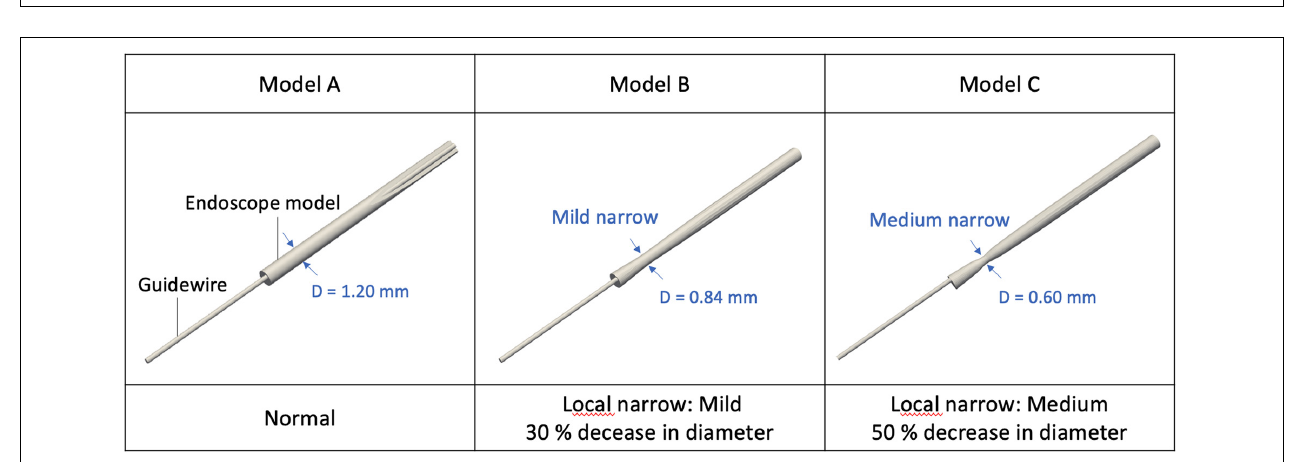
FIGURE 1 | 3D model of the flow channel for simulation of the blood and flush flow behaviour.